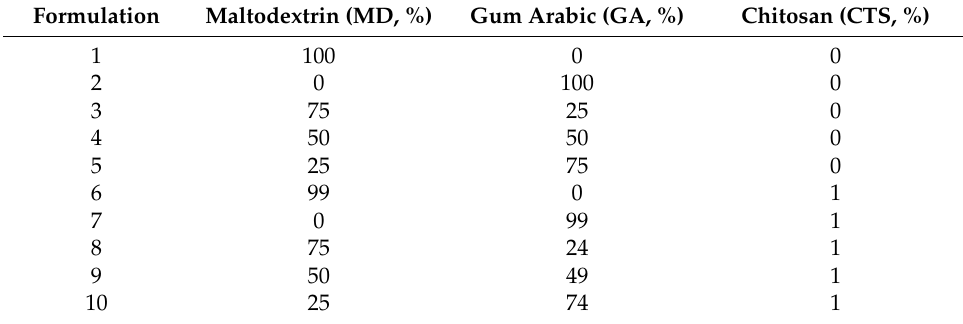
Table 3. Experimental design of biopolymer blends of wall material to form microparticles. Formulation Maltodextrin (MD, %) Gum Arabic (GA, %) Chitosan (CTS, %) 1 100 0 0 2 0